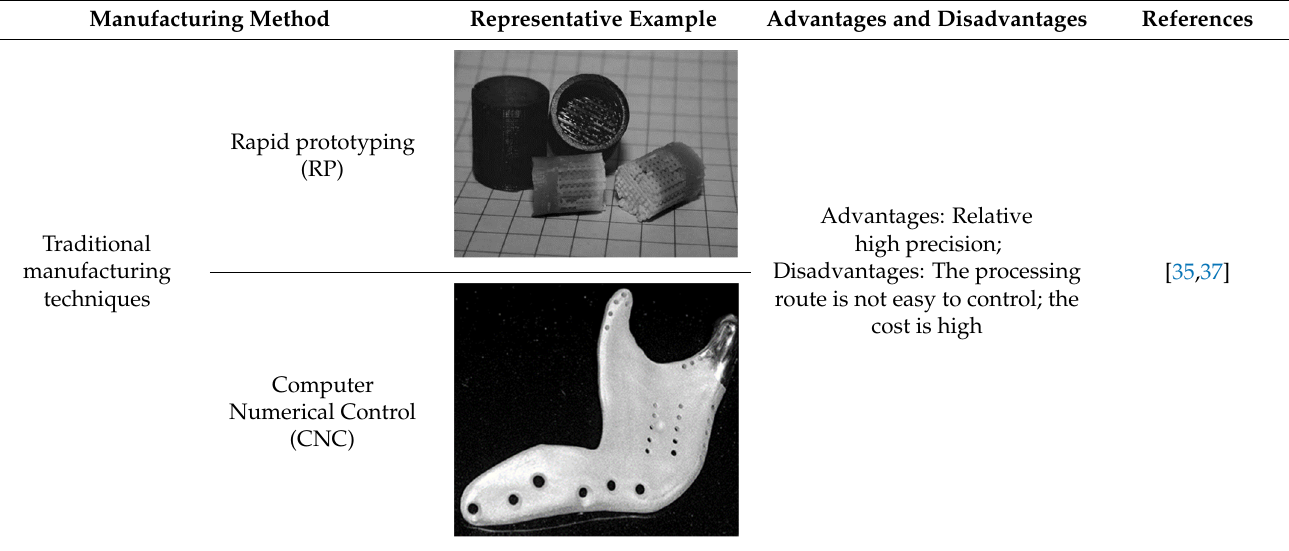
Table 5. A summary of the manufacturing techniques used for producing bone joint replacements.